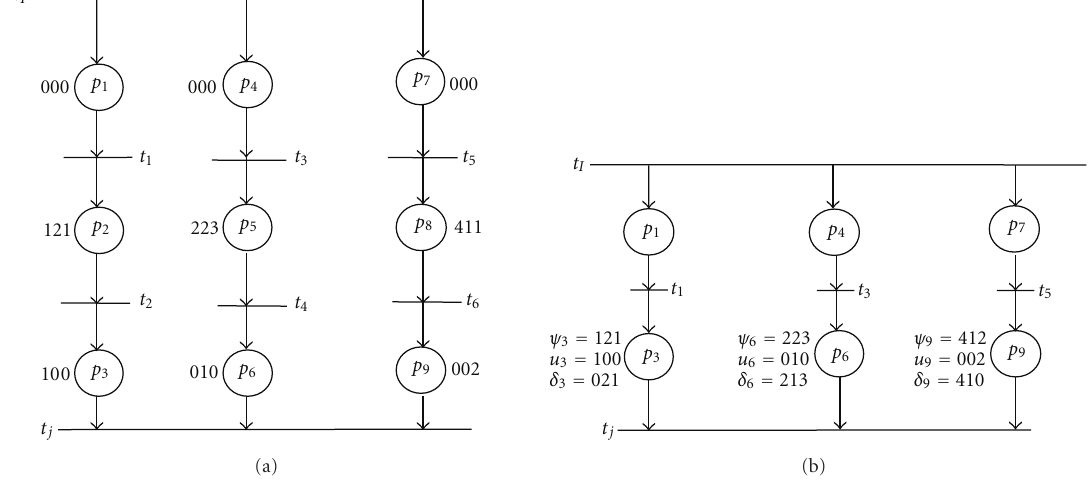
Figure 5: Example for Type-II bound update.